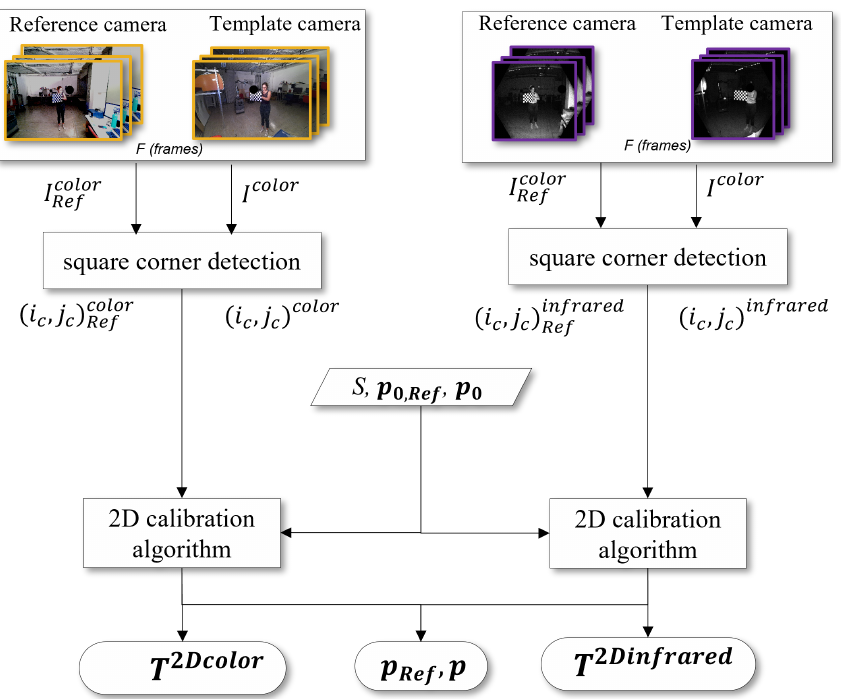
Figure 4. 2D calibration flow chart for the creation of the transformation matrices T 2 Dcolor and T 2 Dinfreared . The frames with color resolution are marked in yellow, while the frames with infrared resolution are marked in